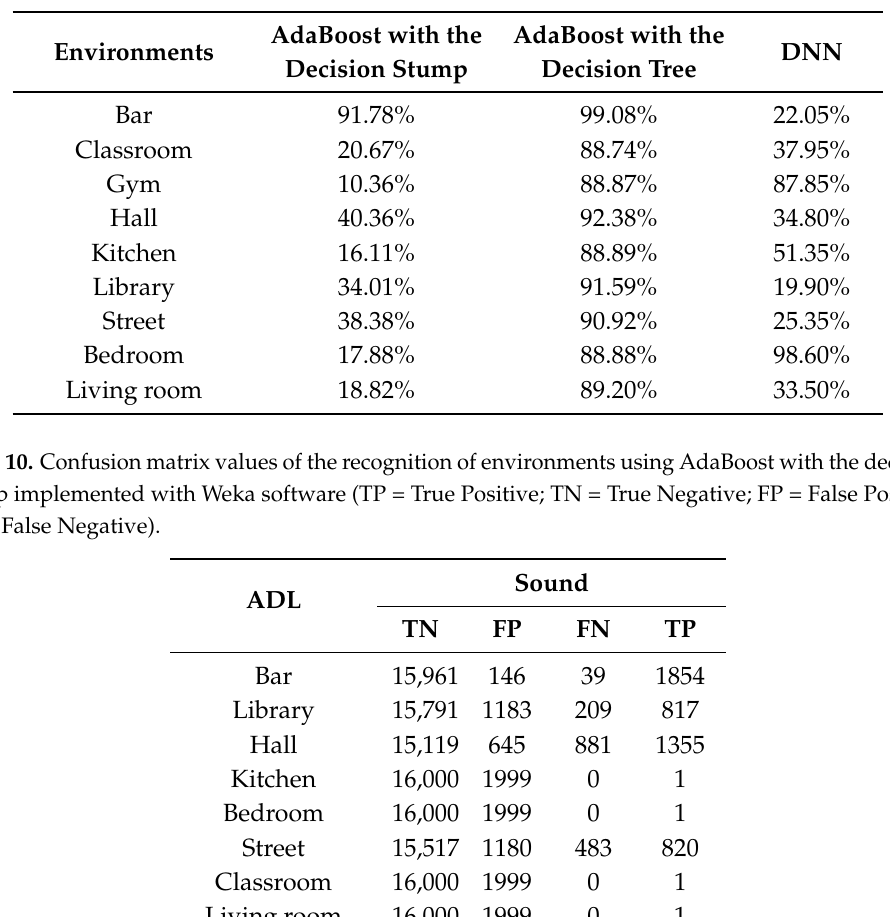
Table 9. Accuracies of recognition of environments using the AdaBoost and DNN methods.